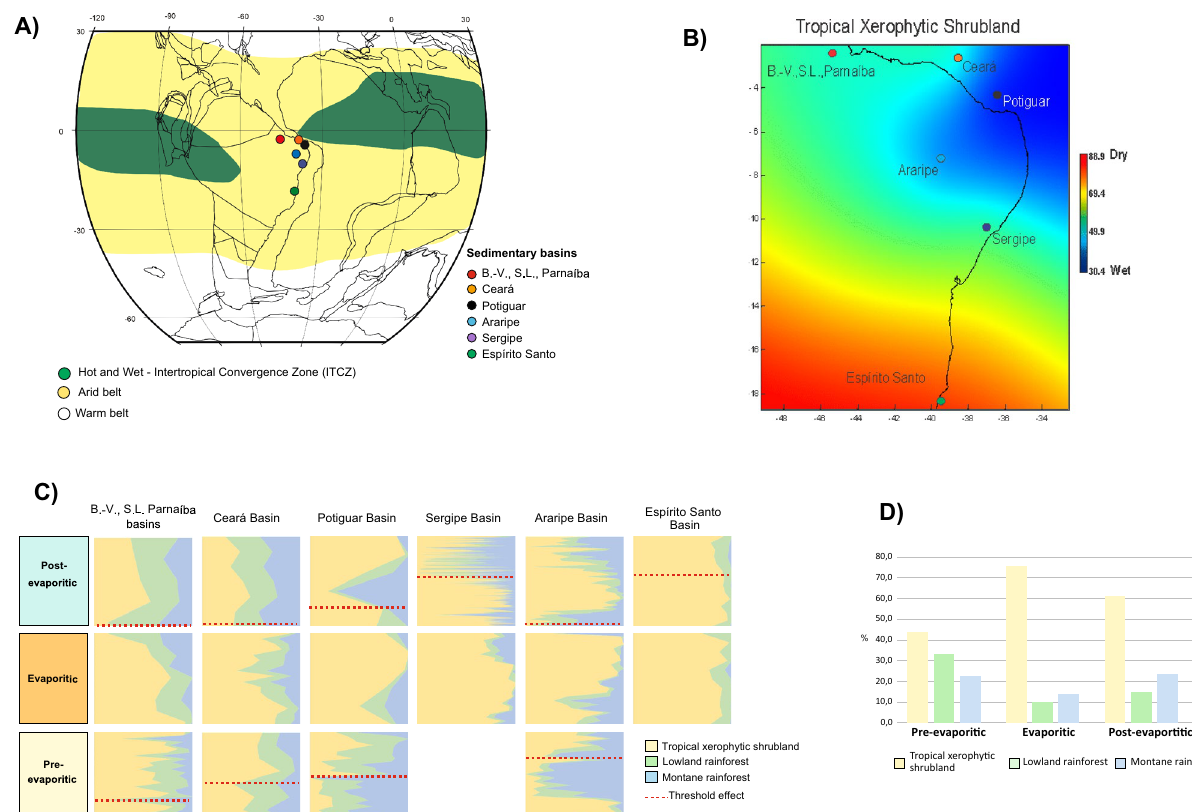
Figure 4. Latitudinal changes in late Aptian biomes from southeast to center-north. ( A ) Paleoclimatic belts of the late Aptian in South America (climatic belts modified from refer. 14 ). Reconstruction map at 116 Ma modified from ODSN Plate Tectonic Reconstruction Service. The Reconstruction map at 116 Ma was generated by ODSN Plate Tectonic Reconstruction Service (https:// www. odsn. de/ odsn/ servi ces/ paleo map/ paleo map. html). ( B ) Late Aptian latitudinal distribution of the tropical xerophytic biome in Brazil. ( C ) Stratigraphic distribution of biomes for individual basins. ( D ) Relative Importance of biomes for paleoclimatic